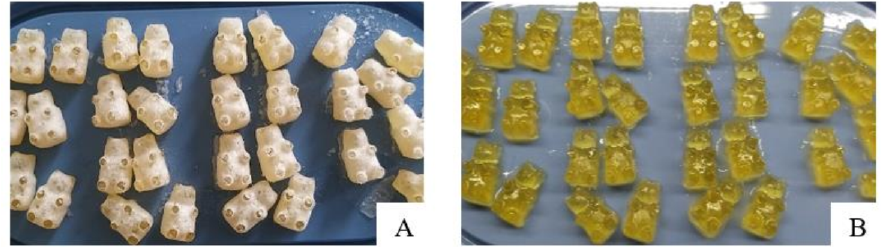
Figure 6. Chewable gel tablets taken out of freezer ( A ) and after 30 min at room temperature ( B ), tablets’ amount per one series is n =